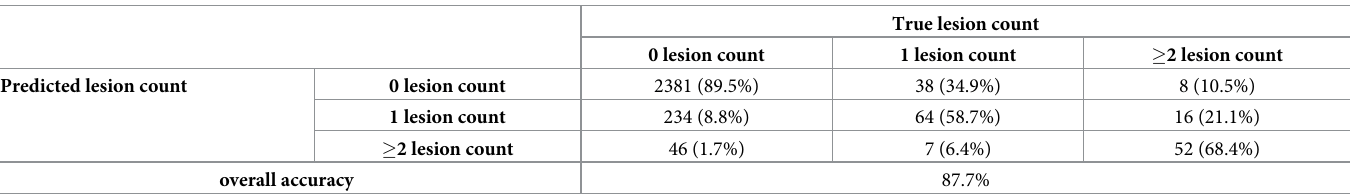
Table 5. Confusion matrix lesion count results on Dataset